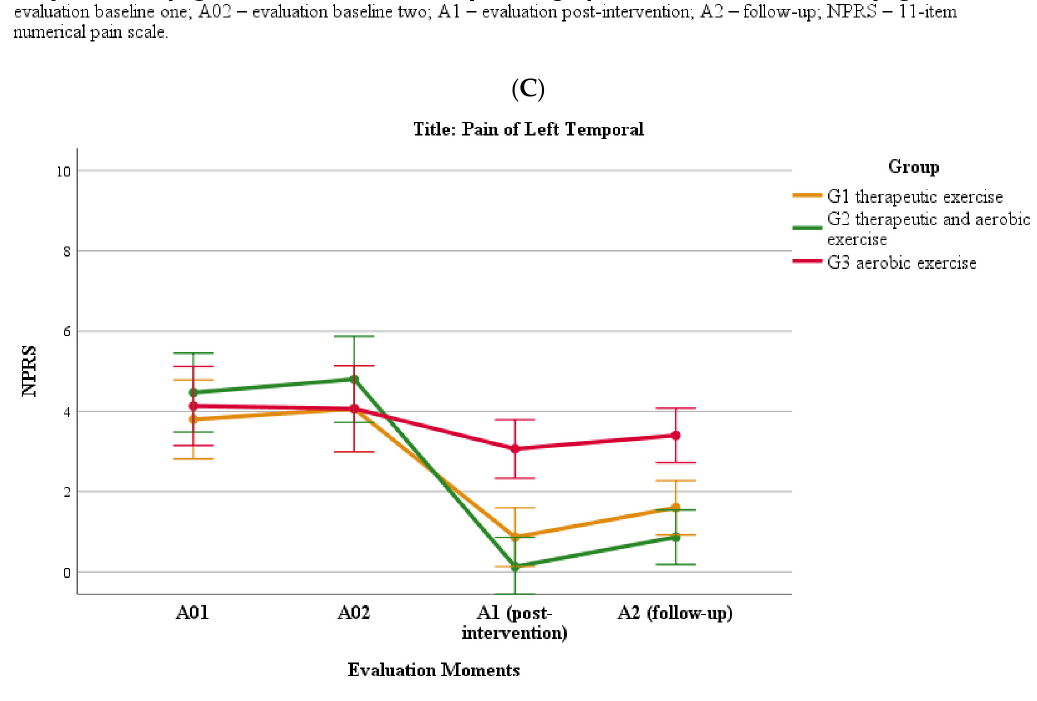
Figure 2. ( A ) Changes in the NPRS of the right masseter muscle at the different time points. ( B ) Changes in the NPRS of the left masseter muscle at the different time points. ( C ) Changes in the NPRS of the right temporal muscle at the different time points. ( D ) Changes in the NPRS of the left temporal muscle at the different time points.